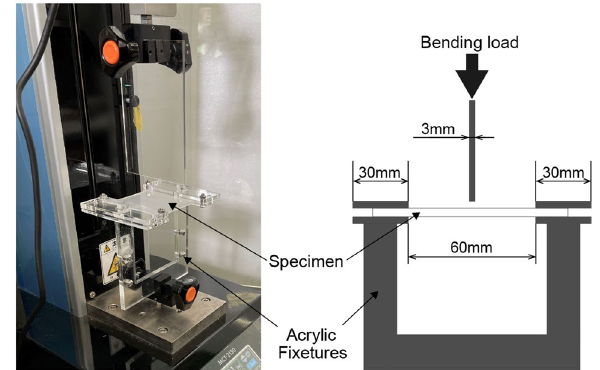
Figure 10. Overview of bulk bending test using a (MCT-2150)